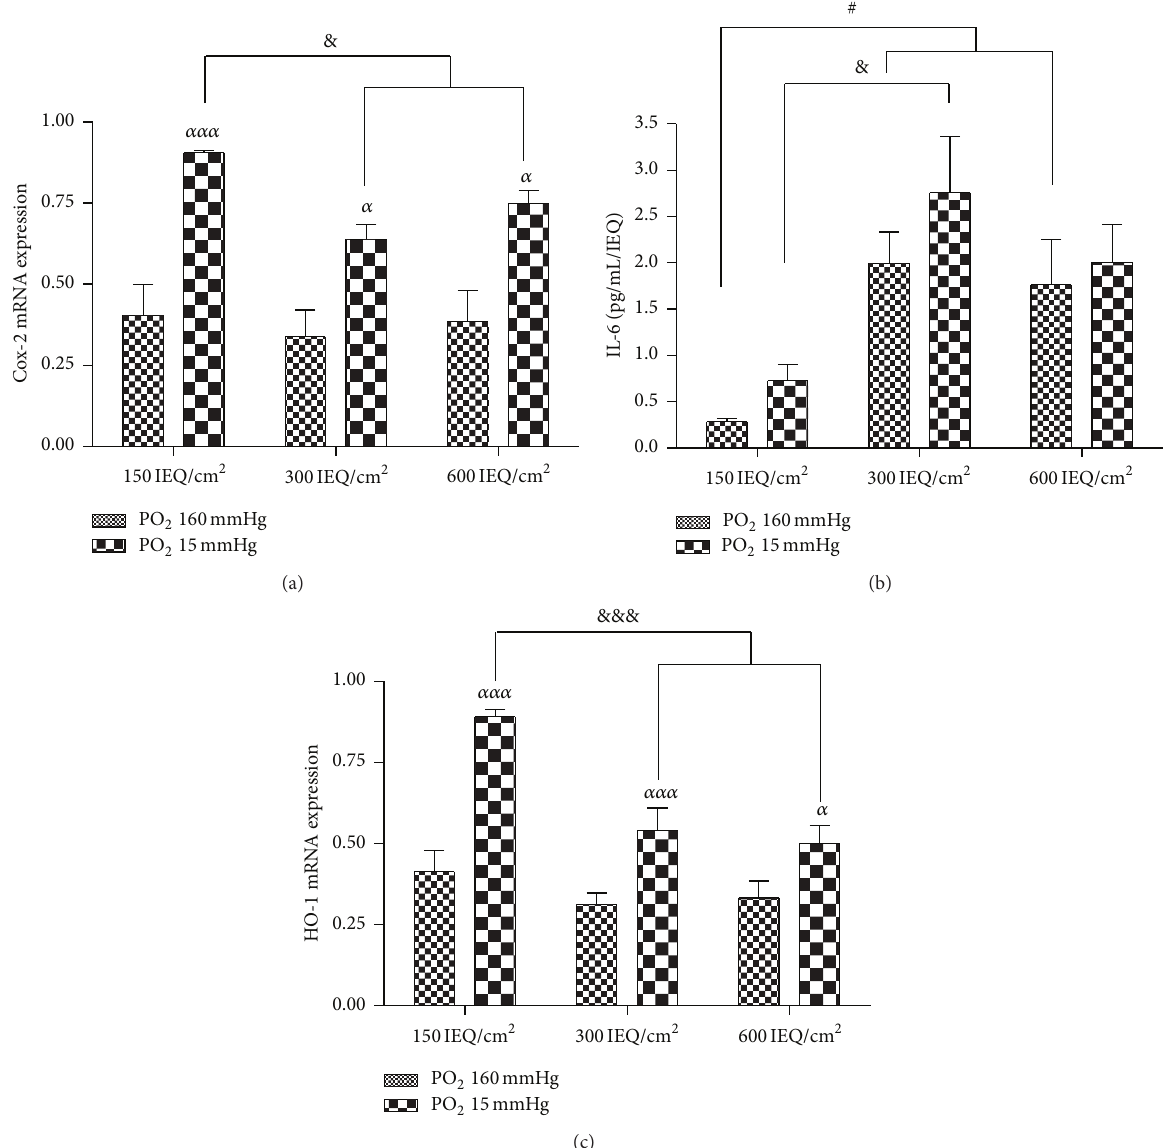
Figure 4: Inflammation. (a) Levels of Cox-2 mRNA expression in islets after 24 hours in culture at 150, 300, and 600 IEQ/cm 2 under normoxic (PO 2 160mmHg) and hypoxic (PO 2 15mmHg) conditions. (b) Levels of Ho-1 mRNA expression after 24 hours in culture under the specified conditions. (c) IL-6 secretion was measured in islet medium after 24 hours in culture under the specified conditions. 𝛼 𝑝 < 0.05 compared to the control, 𝛼𝛼𝛼 𝑝 < 0.001 compared to 150 IEQ/cm 2 under normoxic conditions, # 𝑝 < 0.05 compared to 150 IEQ/cm 2 under normoxic conditions, and & 𝑝 < 0.05 and &&& 𝑝 < 0.001 compared to 150 IEQ/cm 2 under hypoxic